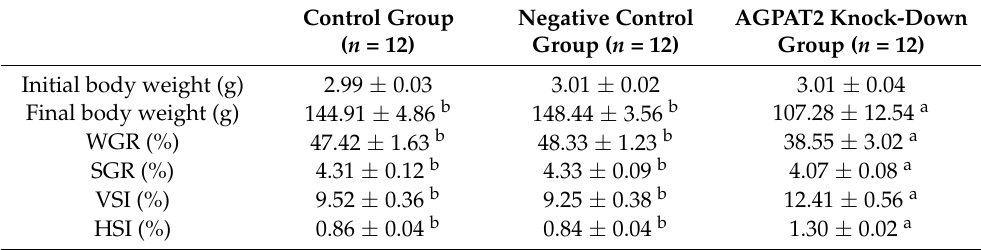
Table 2. Effects of AGPAT2 knock-down on growth indexes.